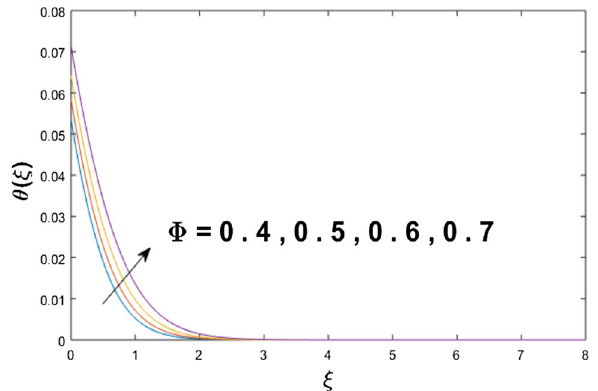
Figure 3. Variations of (cid:31) to θ(ξ) .